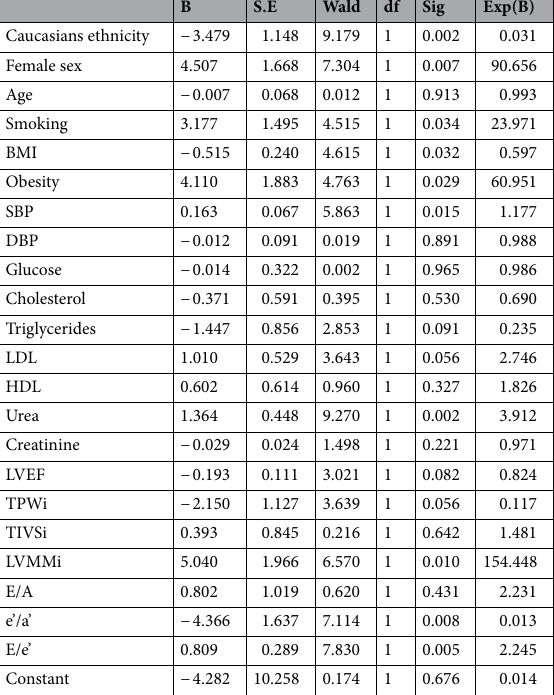
Table 4. Factors associated with the presence of right ventricular diastolic dysfunction (results from binary logistic regression analysis). SBP—systolic blood pressure; DBP—diastolic blood pressure, BMI—body mass index; LDL-low-density lipoprotein; HDL-high density lipoprotein; LVEF—left ventricular ejection fraction; TPWi—posterior wall thickness index, TIVSi—interventricular septum thickness index; LVMMi—LV myocardial mass index, E—early diastolic mitral flow (pulse Doppler); A—late diastolic mitral flow (pulse Doppler); e’ -, a’—early and late diastolic relaxation velocity of lateral mitral annulus (tissue